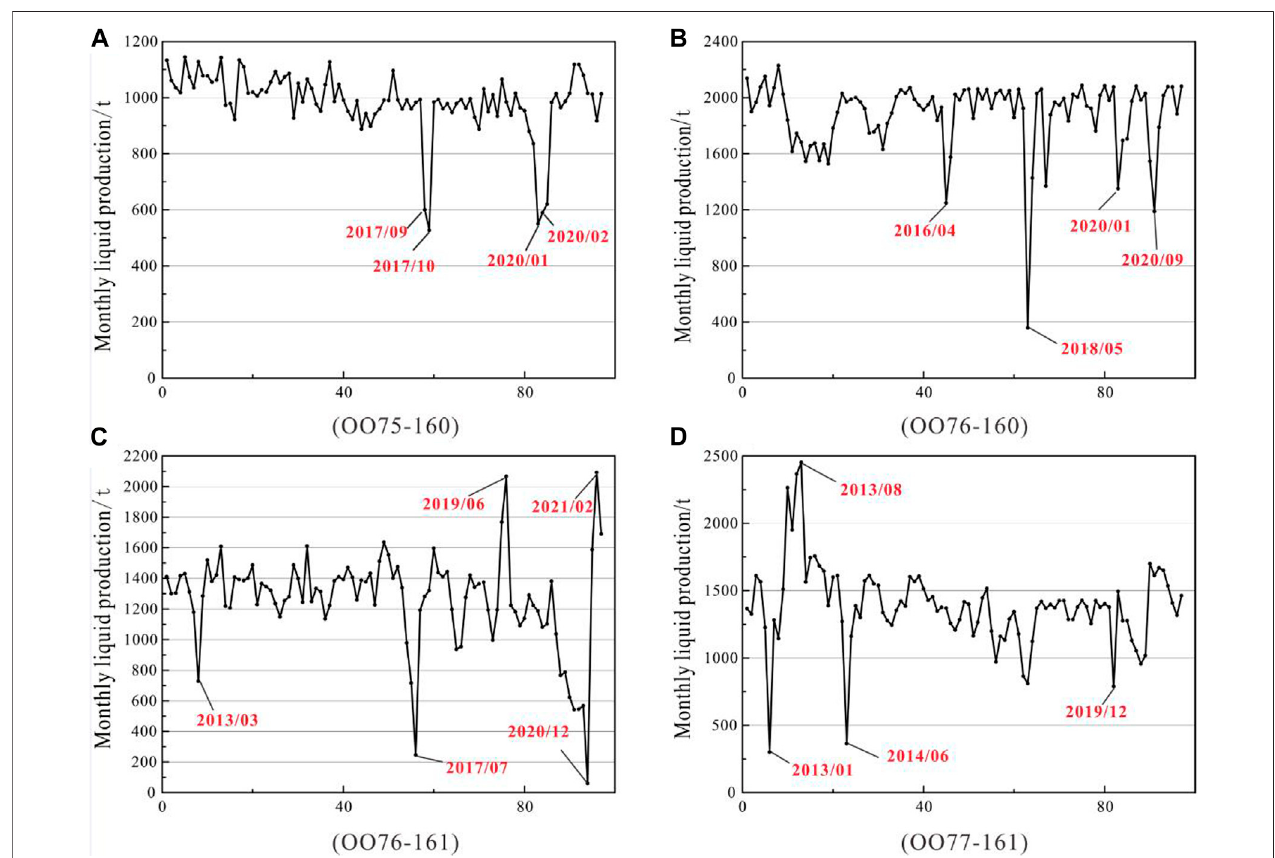
FIGURE 5 | Variations in monthly liquid production of surrounding fi rst-line oil